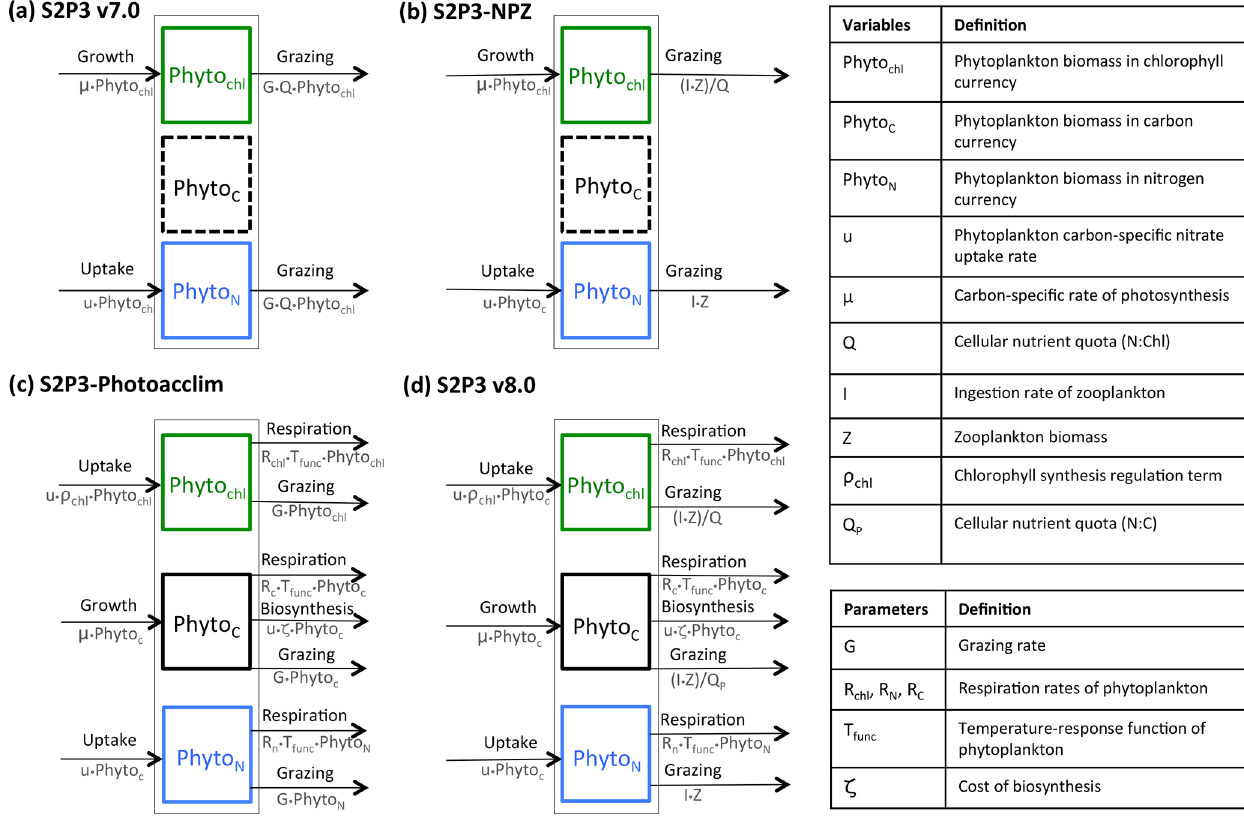
Figure 1. Structure of the phytoplankton growth formulations: (a) S2P3 v7.0 model, with constant Phyto N :Phyto Chl ratio (Q); (b) S2P3- NPZ model, including explicit zooplankton with an associated ingestion rate of phytoplankton (I) based on the Ivlev grazing type; (c) S2P3-Photoacclim model, with varying ratios of N:C:Chl, with phytoplankton chlorophyll content regulated by a coefficient of chlorophyll synthesis ( ρ Chl ), which reflects the ratio of energy assimilated to energy absorbed (Geider et al., 1996), and with phytoplankton carbon regulated through a cost associated with biosynthesis ( uζ ) (Vries et al., 1974; Geider, 1992; Geider et al., 1998), respiration, and grazing ( G ); (d) the S2P3 v8.0 model, including two different varying quotas for Phyto N :Phyto c and Phyto N :Phyto Chl .